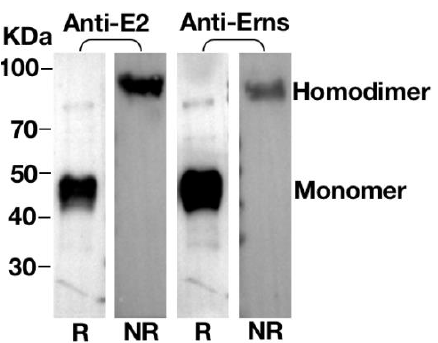
Figure 5. Homodimerization of E rns or E2 proteins. The VLPs were separated by SDS-PAGE under reducing (R) or nonreducing (NR) conditions followed by Western blotting with E rns pAb and E2 mAb 348; on the left protein ladder, the molecular weight in kDa is given. The bands of E rns or E2 monomer and E rns or E2 homodimer are indicated.